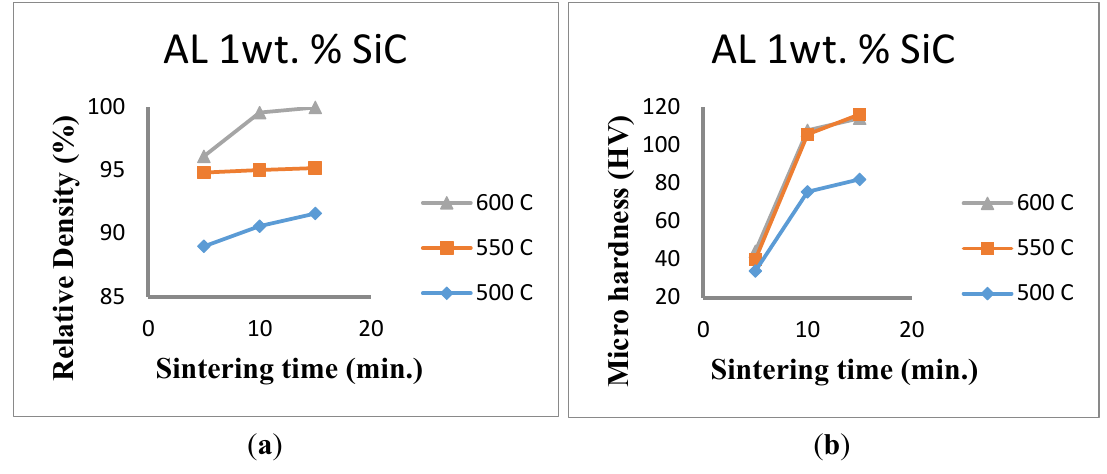
Figure 5. ( a ) Relative density and ( b ) microhardness, as function of sintering temperature and time, of samples sintered using heating rate and pressure of 200 °C/min and 50 MPa, respectively.